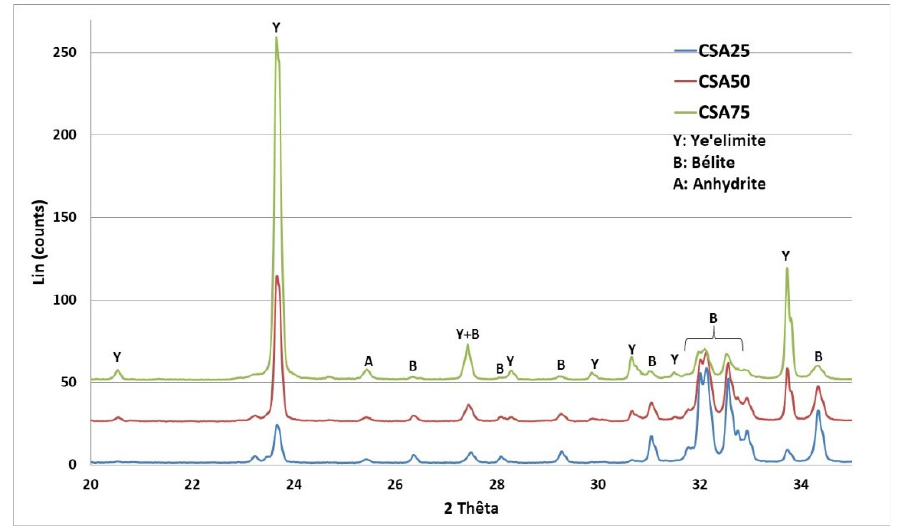
Figure 1. XRD pa tt ern of the three CSA clinkers with di ff erent compositions. Figure 1. XRD pattern of the three CSA clinkers with different compositions. The increase in the ye’elimite content from 25 to 75% (CSA25 to CSA75) increases the intensity of the ye’elimite phases and decreases the belite ones. These fi ndings demon- strate the e ff ectiveness of the laboratory-based clinkering procedure.